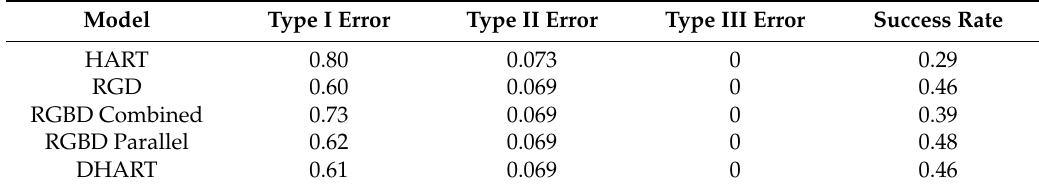
Table 1. Comparison between HART and our three different